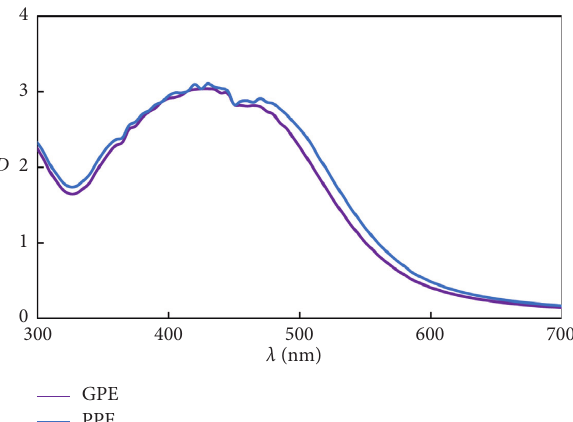
Figure 8: UV-Vis absorption spectra of GPE-AgNPs and PPE-AgNPs after 30min of reaction displaying the characteristic surface plasmon resonance band at 440nm.